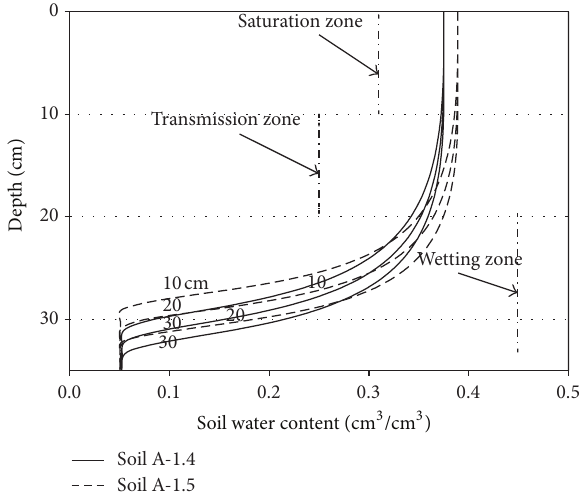
Figure 9: Simulated soil water content profiles after 30min of infiltration in columns of Soil A with two different bulk